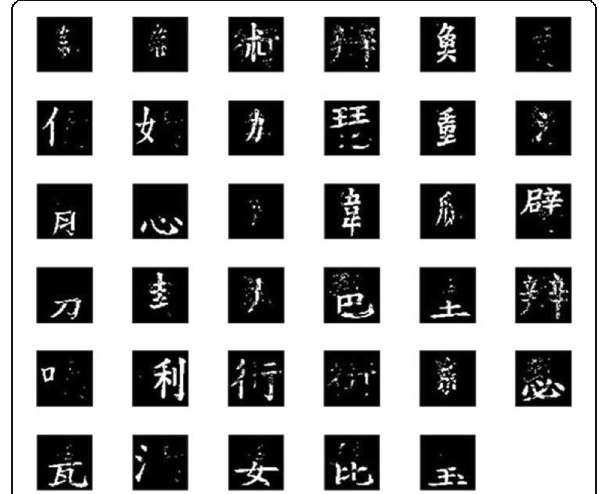
Fig. 6 Visualized basis elements in the matrix W , obtained by factorizing the matrix V , formed by the Chinese characters displayed in Fig. 5